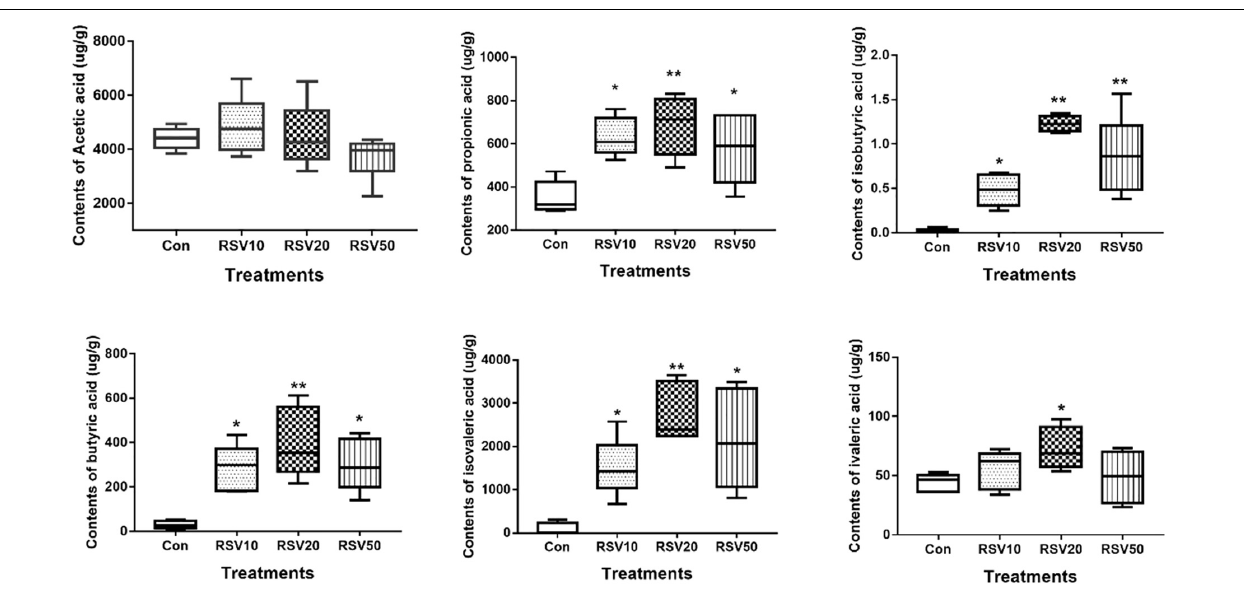
FIGURE 6 | Effect of RSV on the production of fecal SCFAs in weaned mice. The production of fecal SCFAs was determined using the Agilent 6890 gas chromatography. Con = control group, RSV10 = 10 mg/kg RSV, RSV20 = 20 mg/kg RSV, RSV50 = 50 mg/kg RSV. *Means with single asterisks are significantly different ( p < 0.05) from values of control group, and **means with double asterisks are extremely significantly different ( p < 0.01) from values of control group. All the data are expressed as the means ±